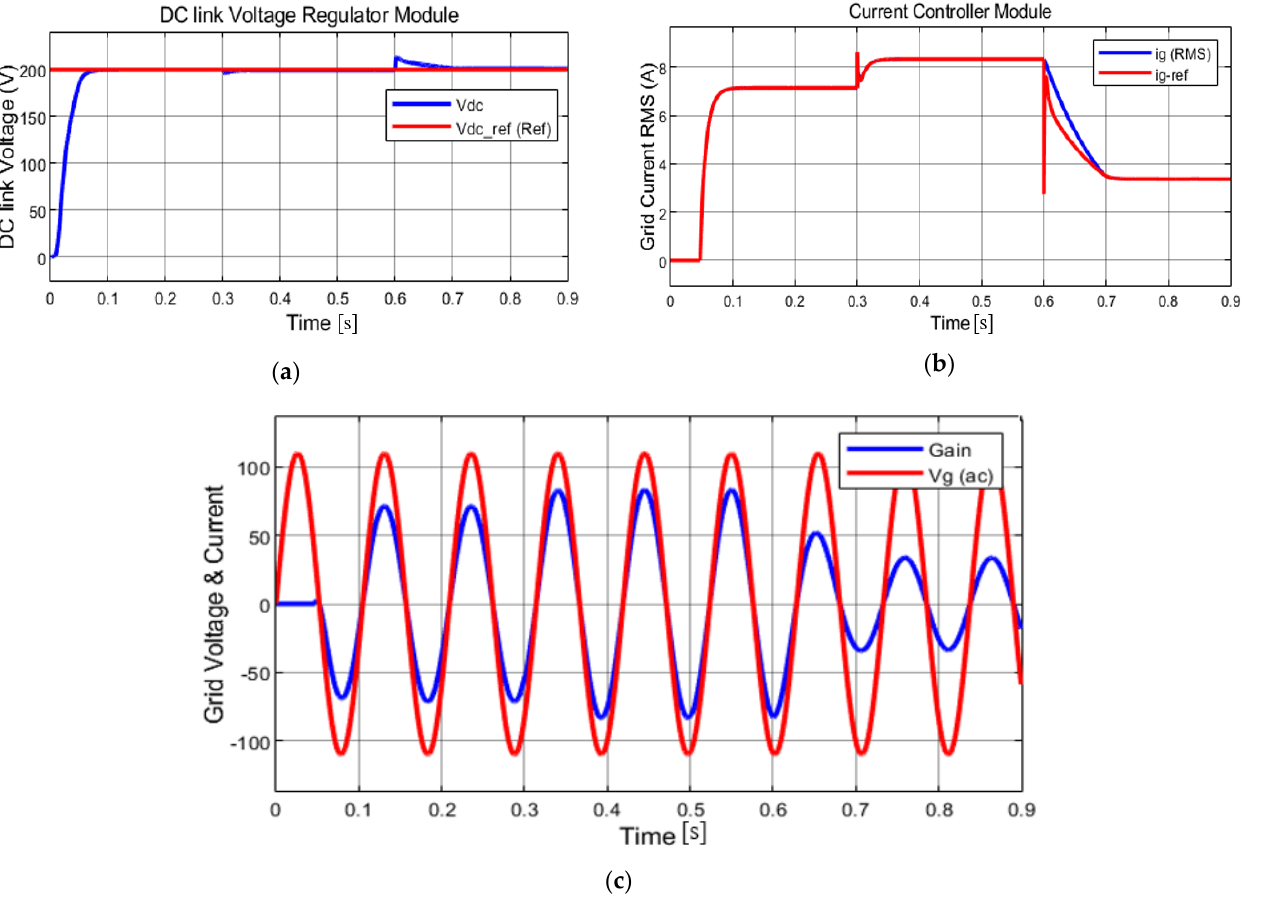
Figure 14. MPPT module performance in case with the backstepping approach for constant temper- ature: ( a ) PV voltage; ( b ) PV output power.